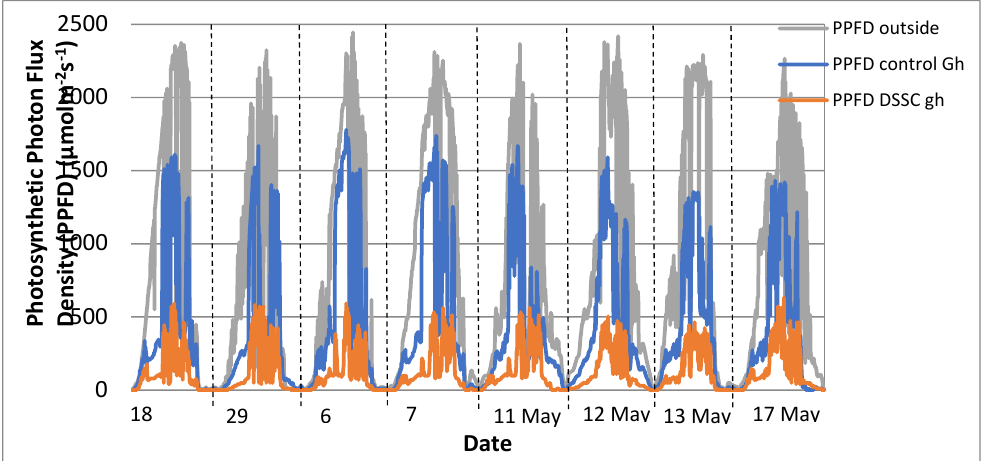
Figure 6. Photosynthetic Photon Flux Density (PPFD) values for outside, the control greenhouse, and the DSSC greenhouse. The PPFD readings outside the greenhouse on bright and sunny days were strong, ranging from 2266.49 to 2445.86 µ mol m − 2 s − 1 while internally the control greenhouse recorded a range of 1363.6 to 1798.4 µ mol m − 2 s − 1 and lower for the DSSC greenhouse with a range of 336 to 474.3 µ mol m − 2 s − 1